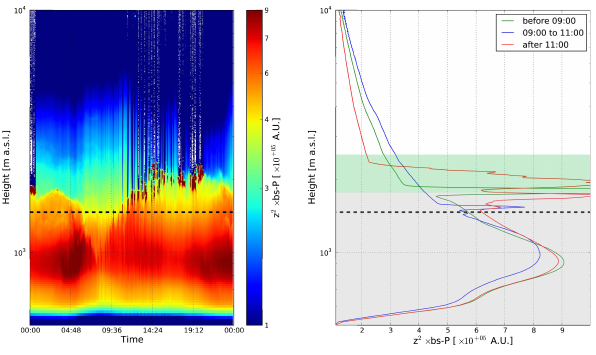
Fig. 14. Left panel: LIDAR z 2 -signal evolution in arbitrary units in case of non-simulataneous nucleation event (21 May 2010). Right panel: average LIDAR z 2 -signal i- before 09:00 (green line), ii- between 09:00 and 11:00 (nucleation time) and iii- after 11:00. On both graphics, the black dot line represents the hight of the puy de Dˆome station.